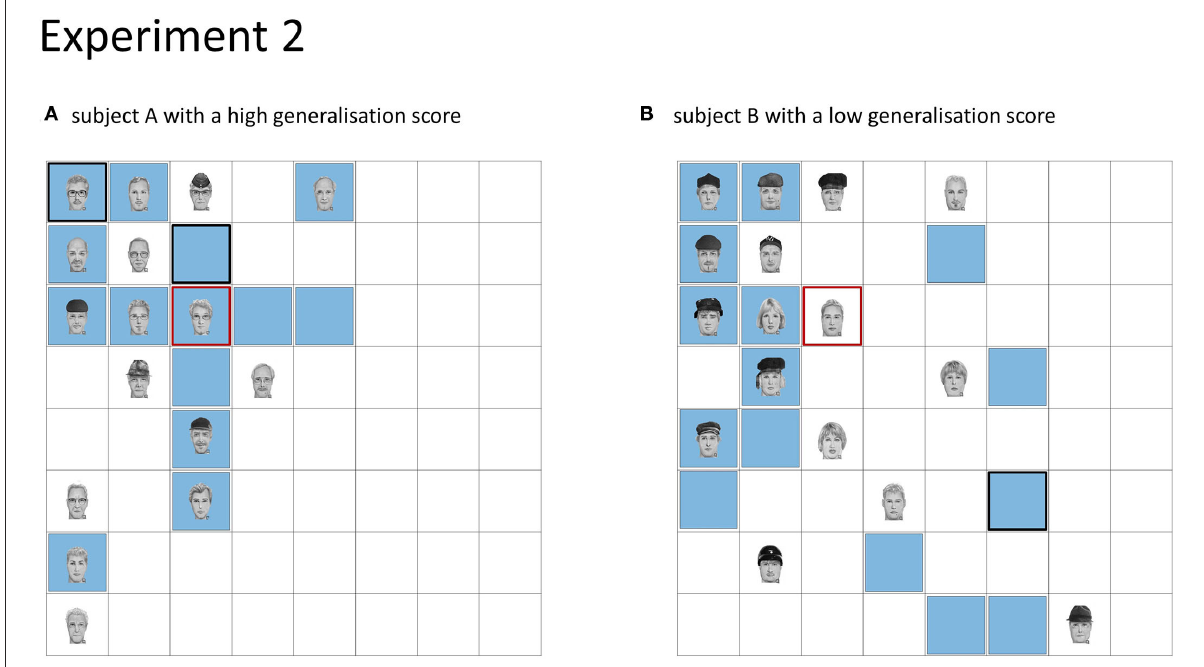
FIGURE4 Depiction of generalisation score. (A) Subject with a high overall generalisation score (0.23). (B) Subject with a low overall generalisation score ( − 1.02). For each subject, one face category with the concomitant hotspot in the left upper quadrant of the board is shown. The red square shows the location of the hotspot, the faces show the learned face locations, and locations, where the subject placed a face during recall are indicated by blue squares. Locations, where the subject placed a face twice, are shown by a thicker black. For subject A with a positive generalisation score, recalled locations are closer to the hotspot.